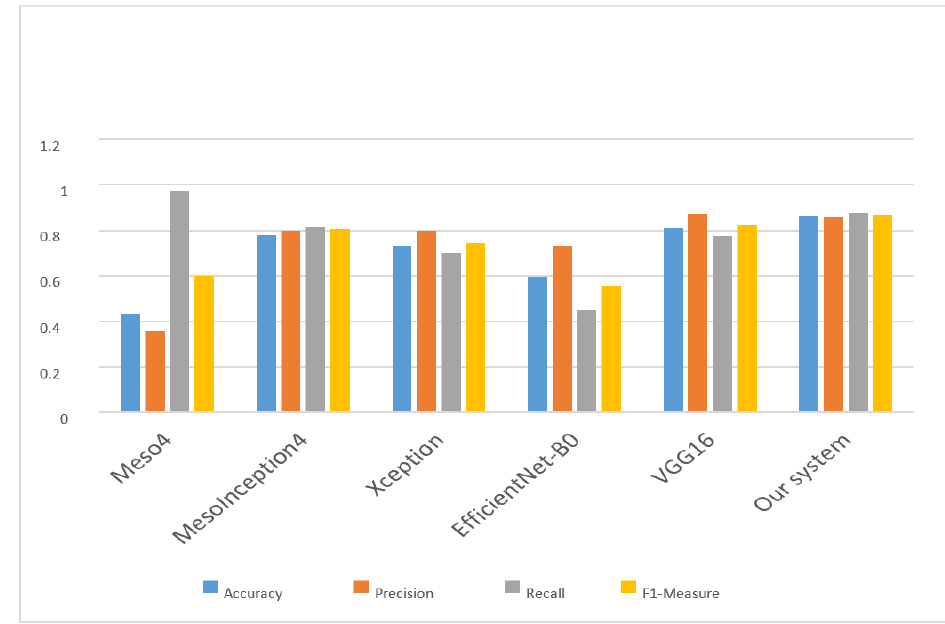
Figure 13. Performance evaluation